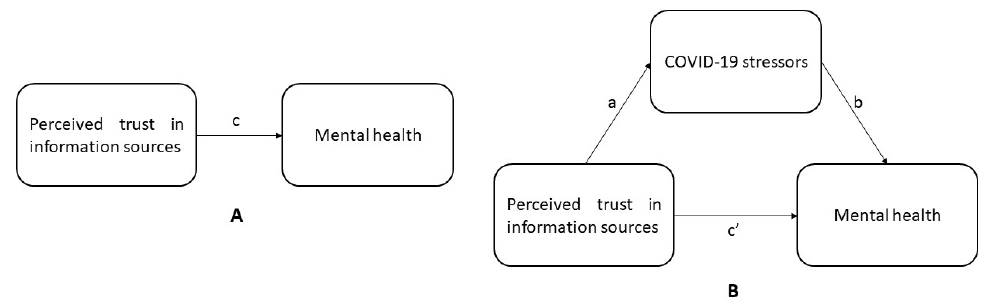
Figure 1. Conceptual framework showing hypothesized associations between perceived trust in sources of COVID-19 information and mental health ( A ); including hypothesized mediation by COVID-19 related stressors ( B ). In the mediation model, “a” denotes the predictor’s direct effect on the mediator, “b” denotes the mediator’s direct effect on the outcome variable, “c” denotes the predictor’s direct effect on the outcome, and “c ′ ” denotes the predictor’s direct effect on the outcome after controlling for the predictor’s indirect effect on the outcome via the mediator.